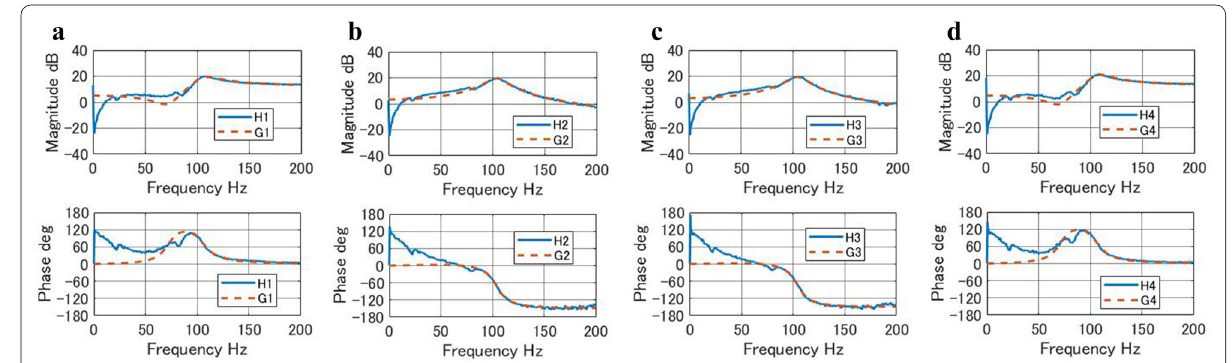
Fig. 4 Measured frequency responses and frequency responses of identified transfer functions. a H 1 and G 1 , b H 2 and G 2 , c H 3 and G 3 , d H 4 and G 4